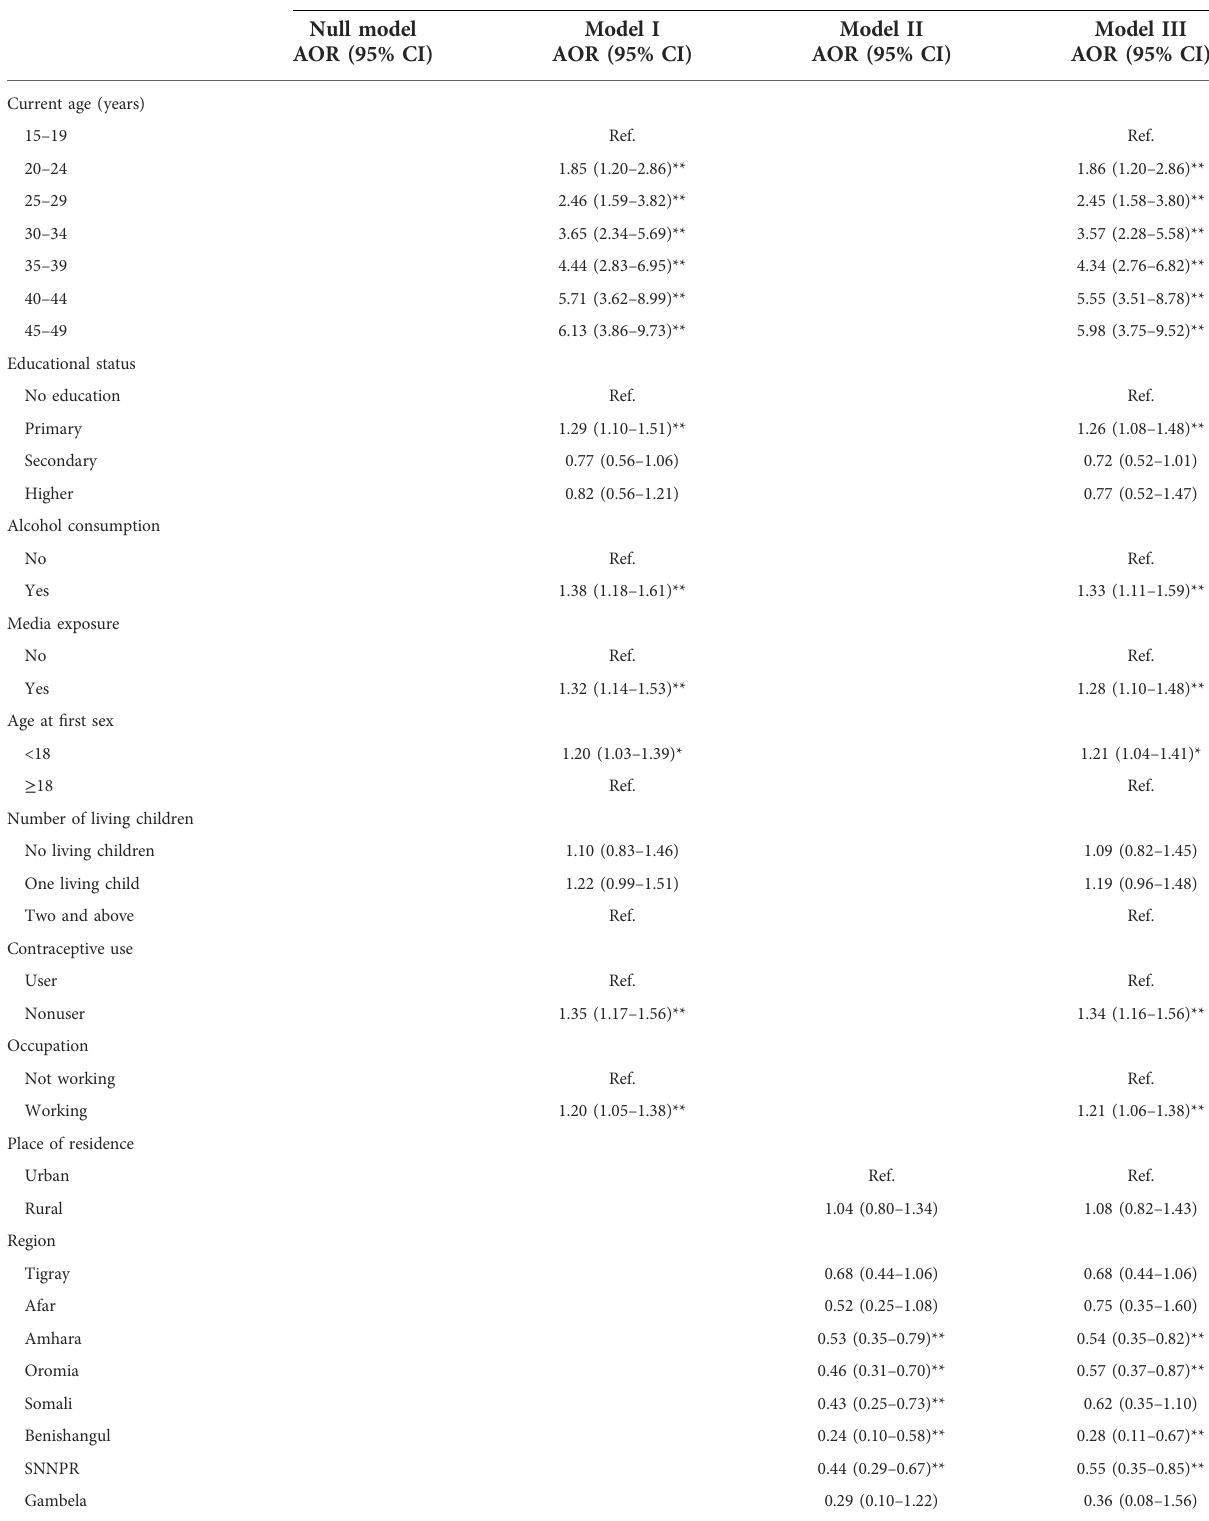
TABLE 3 Multivariable multilevel mixed-effects logistic regression analysis of factors associated with abortion among ever-married reproductive- age women in